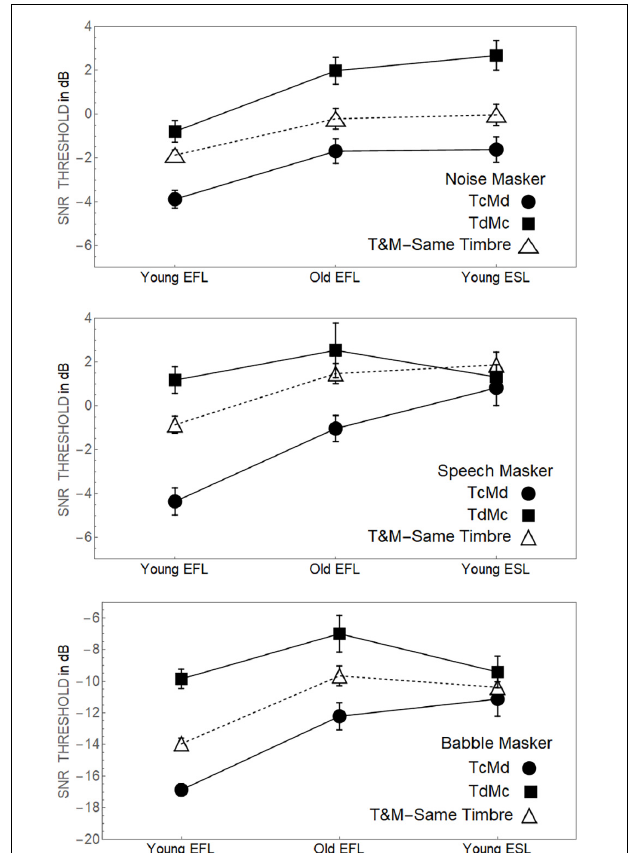
FIGURE 3 | Top panel. Fifty percent thresholds when the masker was speech spectrum noise for the three groups listening to sentences where the target was either compact or diffuse with the masker having the opposite timbre. Middle Panel. The equivalent data when the participants were listening to the sentences when the background is competing speech. Bottom Panel. The equivalent data when the participants were listening to the sentences when the background is babble. Standard error bars are